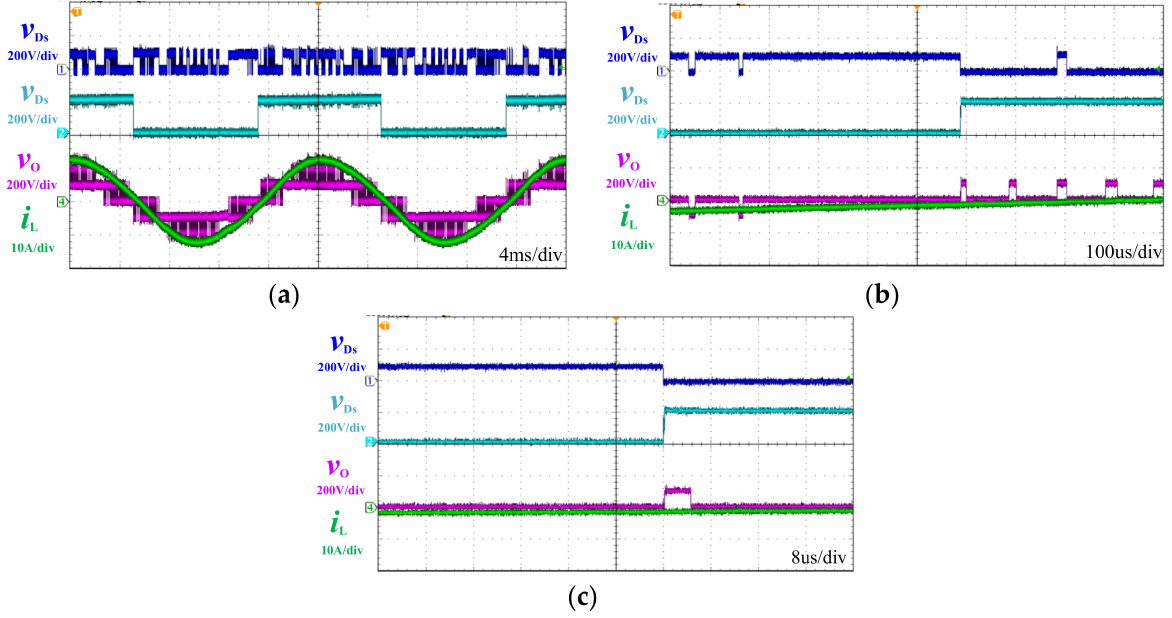
Figure 19. The waveform under the proposed modified modulation strategy. ( a ) Under fundamental frequency. ( b ) Under multiple switching cycles. ( c ) Under single switching